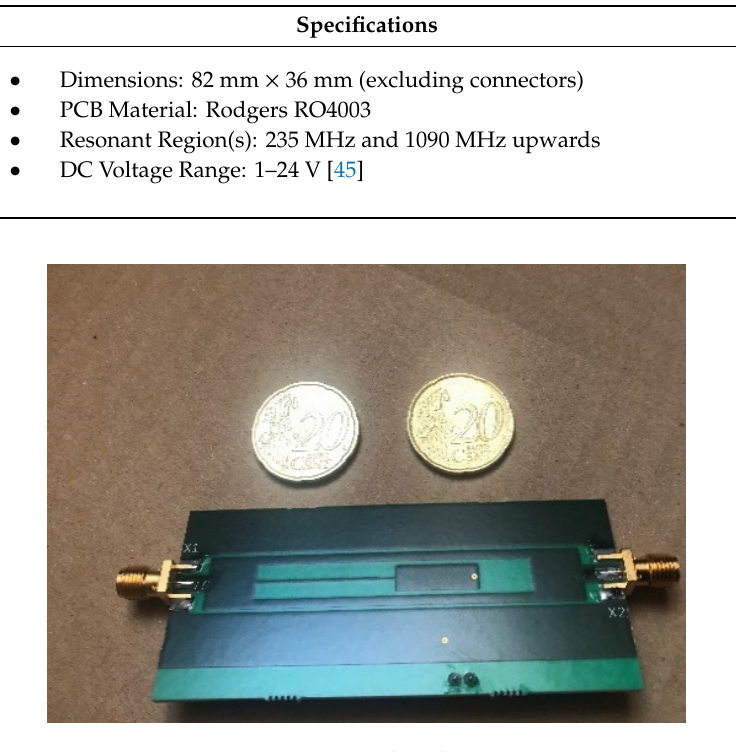
Figure 2. Developed Tag.